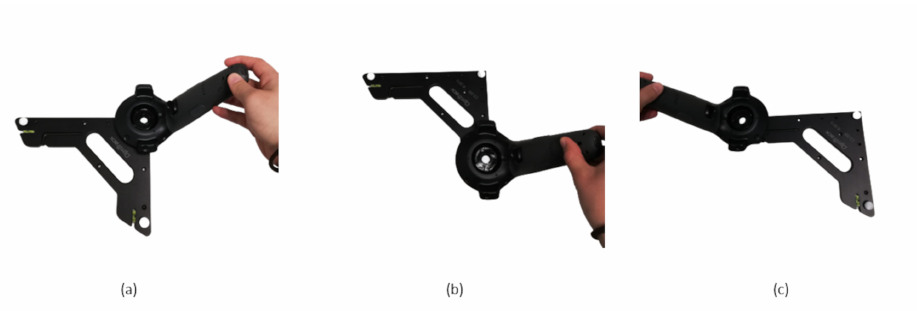
Figure 7. Referential definition on the HTC Vive application: ( a ) Step 1. ( b ) Step 2. ( c ) Step